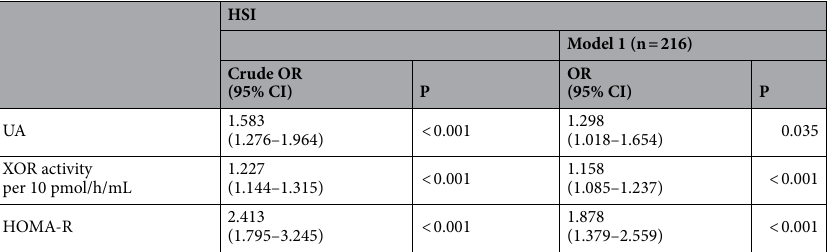
Table 5. Logistic regression analyses of the factors associated with hepatic steatosis index (HSI). In model 1, an ordinal logistic regression analysis was performed with HSI as the objective variable and serum uric acid (UA) levels, plasma xanthine oxidoreductase (XOR) activity, and homeostasis model assessment ratio (HOMA-R) as explanatory variables. OR, odds ratio; CI, confidence